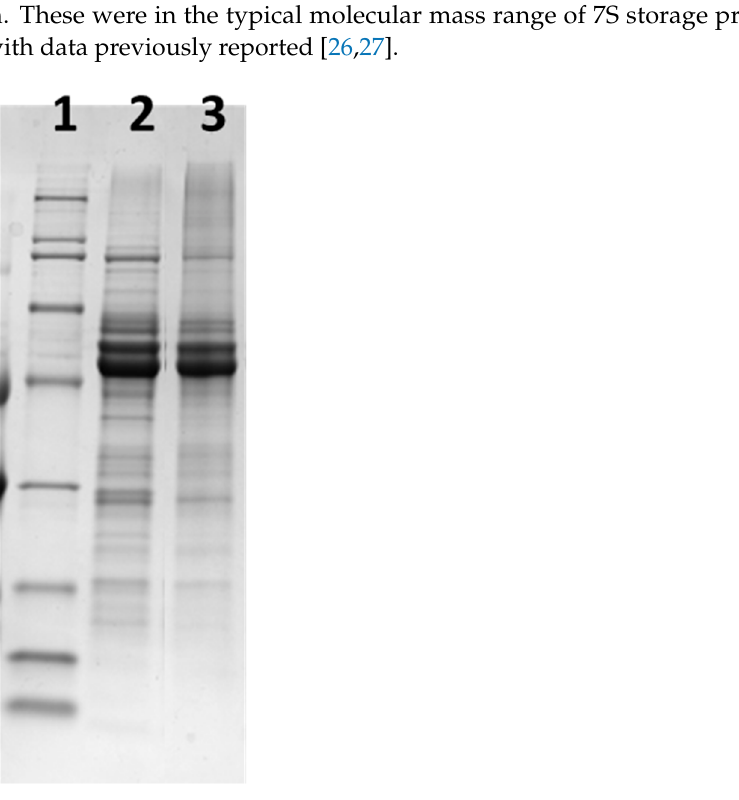
Figure 1. SDS-PAGE of CPF (2) and CPPC (3) with molecular weight markers (1). Proteins were stained with Coomassie blue.